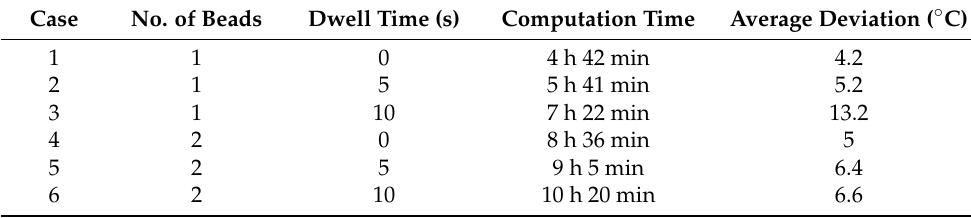
Table 3. Experiment cases examined for thermal model validation via thermocouple.